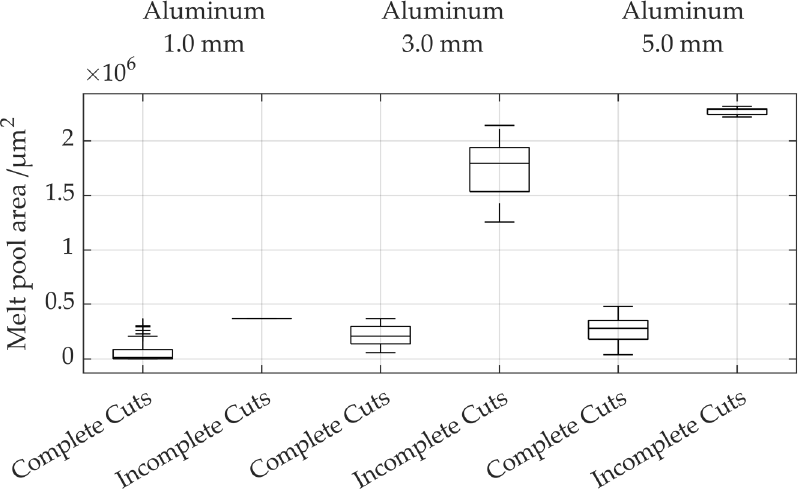
Figure 10. Comparison of the distribution of the melt pool area for complete and incomplete cuts in aluminum.